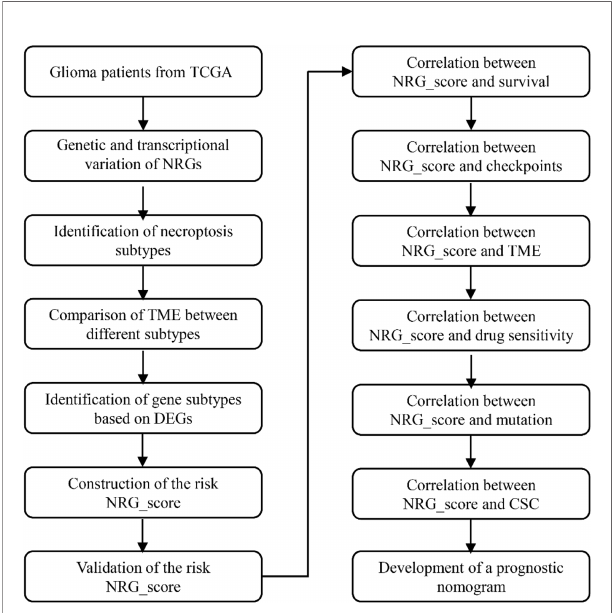
FIGURE 1 | The entire analytical process of the